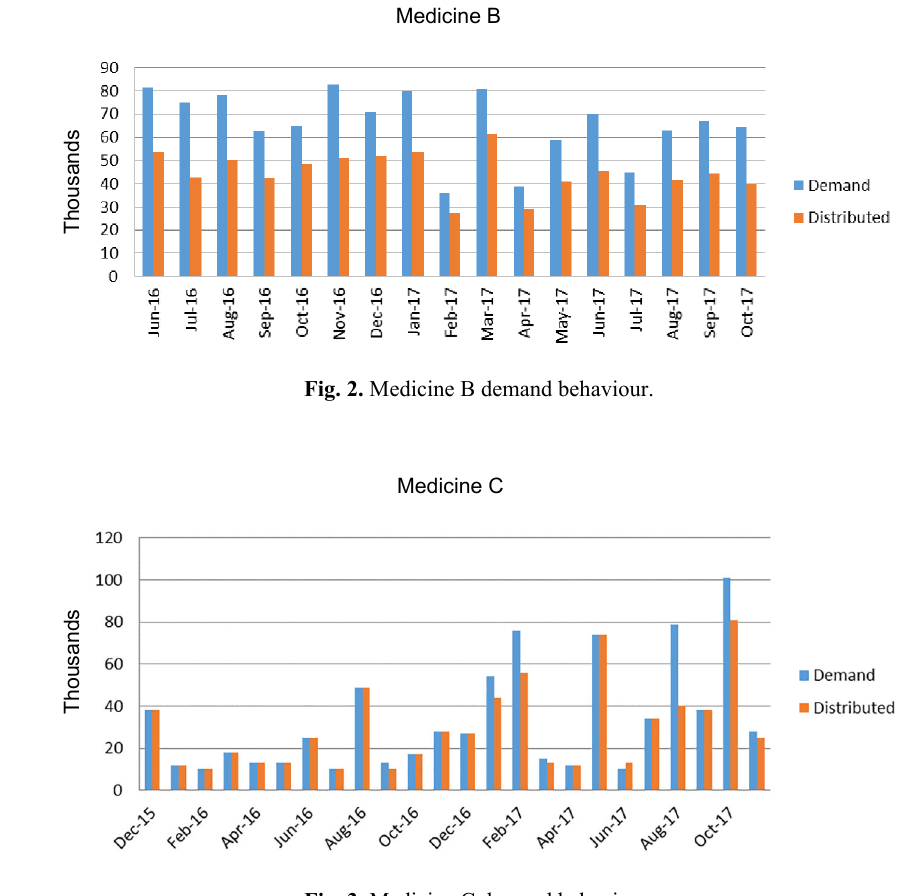
Fig. 3. Medicine C demand